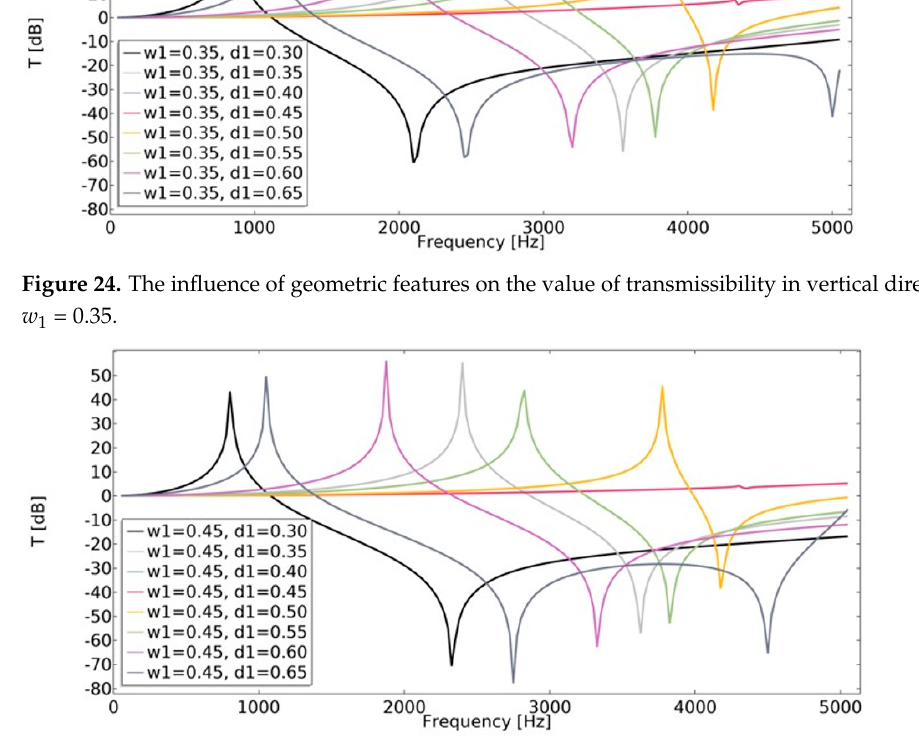
Figure 25. The influence of geometric features on the value of transmissibility in vertical direction for w 1 = 0.45.